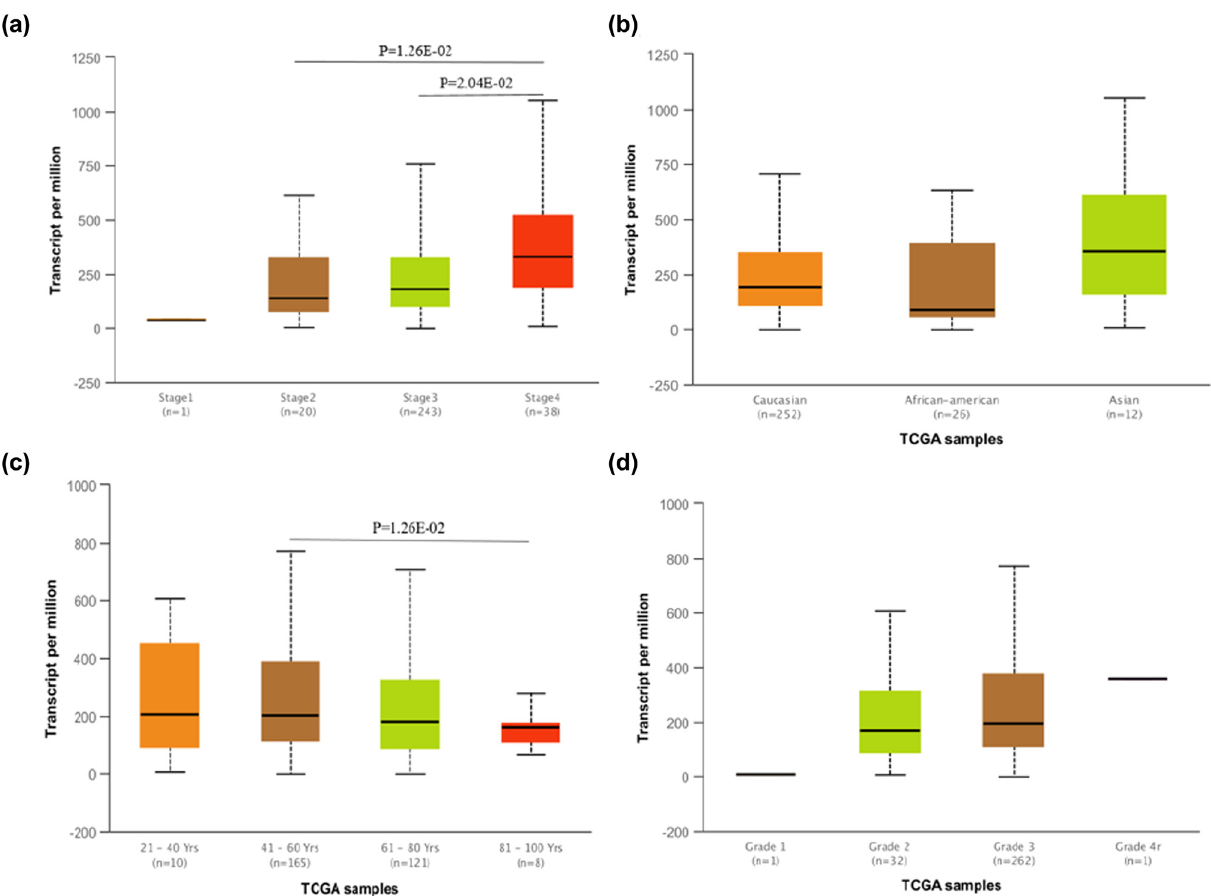
Figure 5: The relative expression of KLK7 in ovarian cancer. ( a ) Expression of KLK7 in OV based n individual cancer stages, ( b ) expression of KLK7 in OV based on patient's race, ( c ) expression of KLK7 in OV based on patient's age, ( d ) expression of KLK7 in OV based on tumor